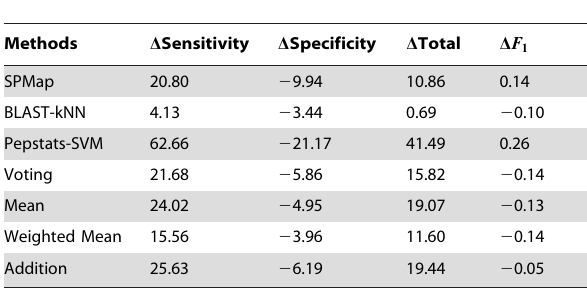
Table 4. Changes in sensitivity and specificity, total change and change in F1 score when threshold relaxation is applied.